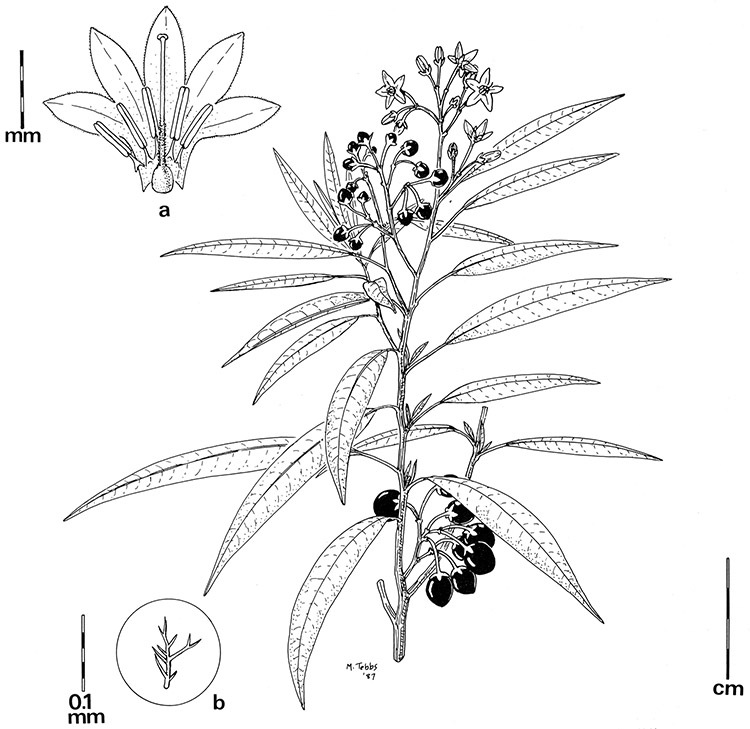
Solanum nitidum Ruiz & Pav. (A–B drawn from D.N. Smith 1622). Reproduced from Knapp (1989) with permission of the Natural History Museum Botany Library. Illustration by Margaret Tebbs.